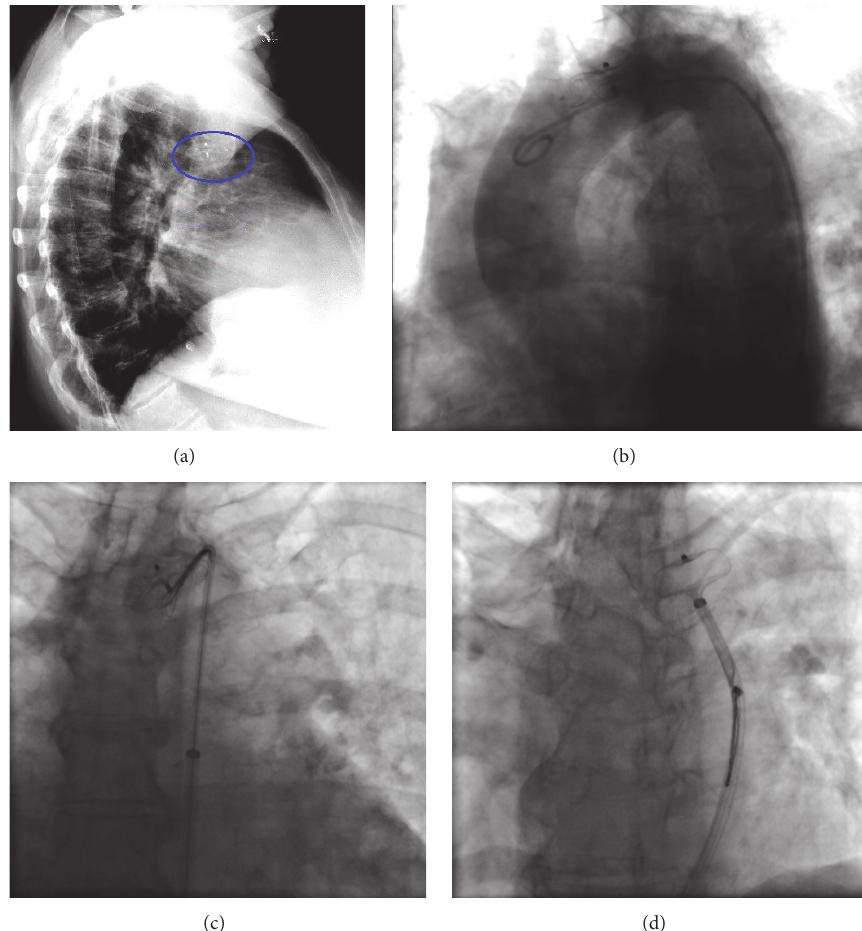
Figure 2: (a) Chest radiograph, lateral view showing the embolized ASO. (b) Aortic arch angiography using angled pigtail catheter. (c) Using En-Snare, capturing of the metallic tip of the right atrial disc of the ASO. (d) Retraction of the entire ASO into the long cook